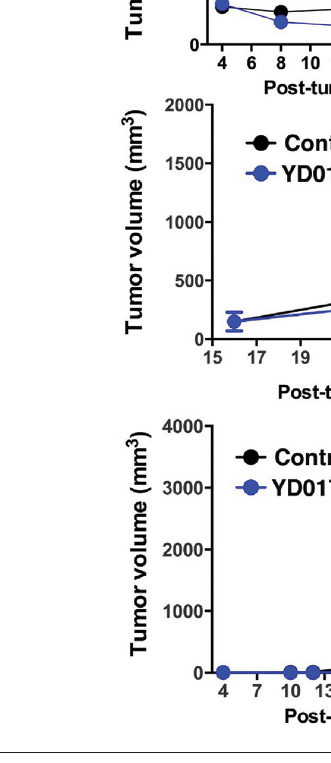
Figure 15. Effect of YD0171 on PDTX growth in nude mice. PDTX of three different colon cancer patients (top, middle and bottom panels) showing different growth rates. YD0171 (3 mg/kg/d) inhibited tumor growth in all experiments. * p < 0.05 and ** p < 0.01 indicate a significant inhibitory effects. Data are shown as mean ± SEM values of n = 4–6 animals per